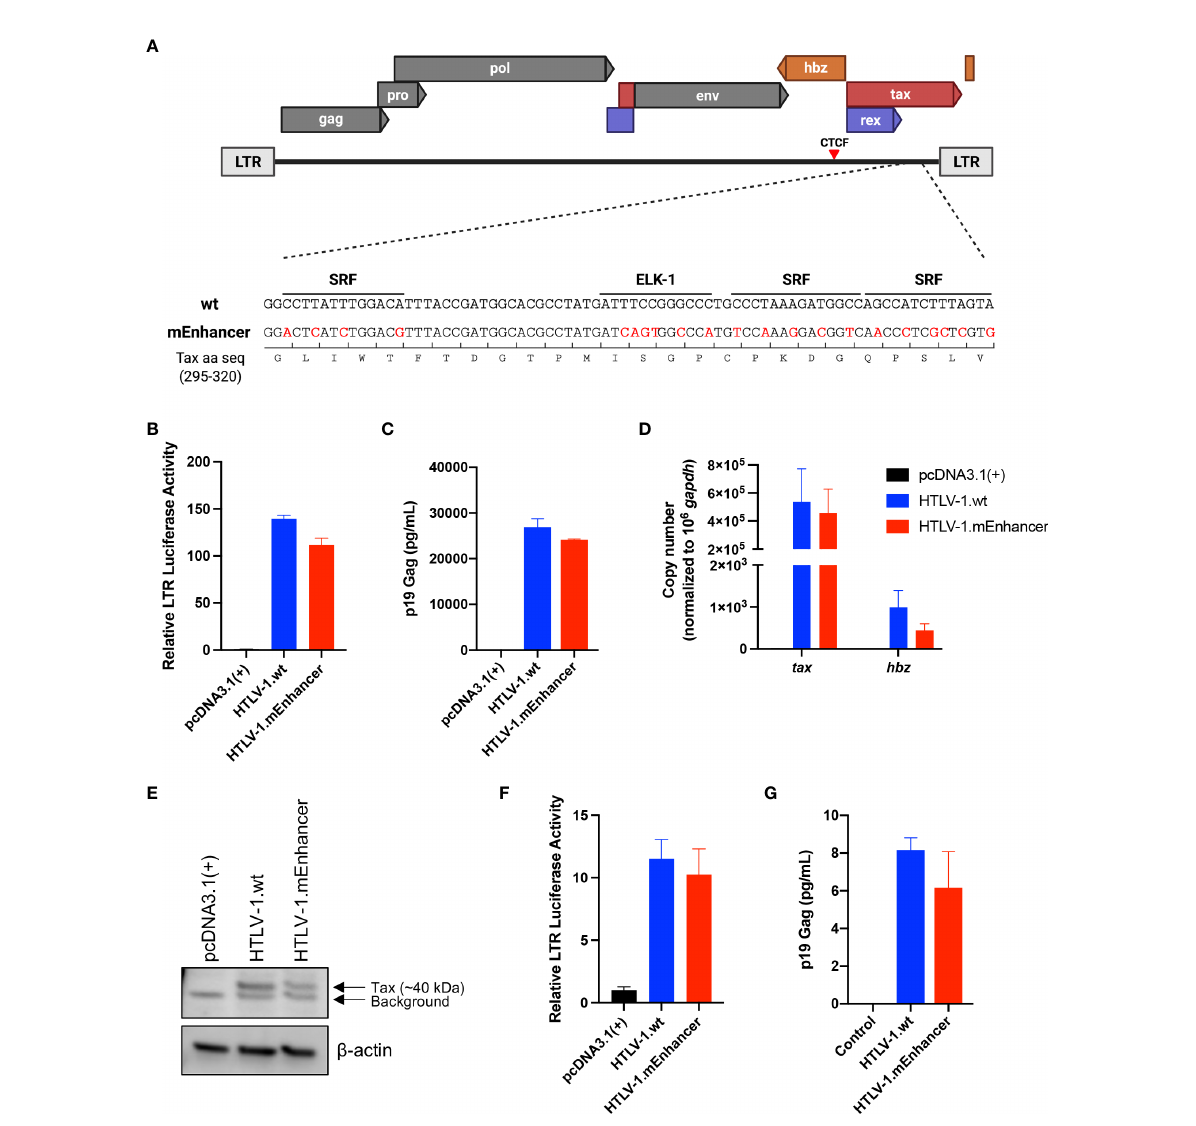
FIGURE 1 Generation and characterization of HTLV-1.mEnhancer proviral clone in vitro . The mEnhancer region was cloned into the HTLV-1 proviral plasmid ACHneo by overlap extension PCR. (A) Alignment of the mEnhancer region and the wild-type region from the HTLV-1 molecular clone ACHneo. Mutations span the consensus binding sequences for the transcription factors SRF and ELK-1. (B) HEK293T cells were co-transfected with the pcDNA3.1(+) empty vector, HTLV-1.wt, or mutant (HTLV-1.mEnhancer) proviral plasmid, an HTLV-1 LTR- fi re fl y luciferase construct, and a TK-Renilla luciferase construct. 72h post-transfection, cells and supernatant were collected for dual luciferase assay and ELISA to detect HTLV-1 p19 Gag (C) , respectively. Relative LTR luciferase activity was determined by normalizing fi re fl y luciferase relative light units to Renilla, and the empty vector control was set as 1. Each condition was performed in duplicate. (D) RNA was extracted from transfected cells for cDNA synthesis, followed by qPCR to detect tax and hbz mRNA levels. Copy number is shown normalized to 1 x 10 6 gapdh copies. (E) Cells pellets from transfected cells were lysed and total protein was quanti fi ed by BCA assay. Equivalent amounts of protein were subjected to SDS-PAGE and immunoblotting to detect Tax expression. b -actin was used as a loading control. Arrows are used to distinguish bands representative of